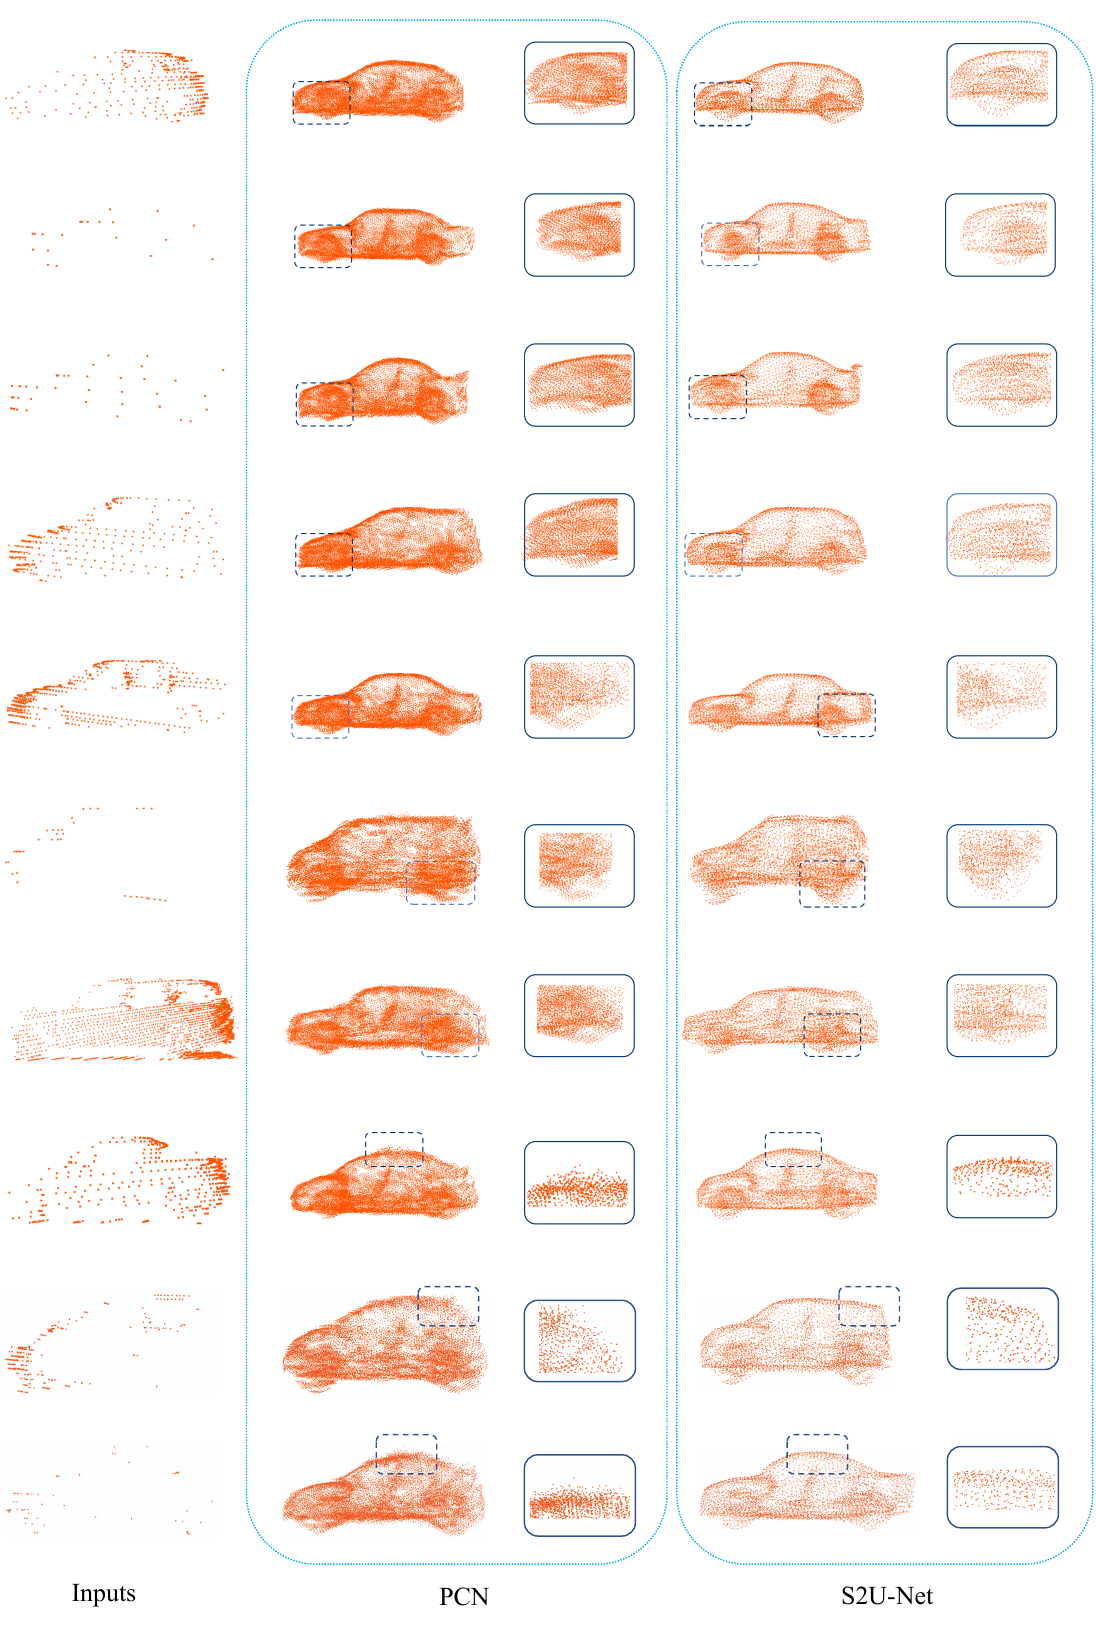
Figure 3. 3D point cloud completion for the shape of cars from the KITTI dataset. The orders from left to right: input partial scans, PCN and S2U-Net. Note that these completed point clouds all have 16,384